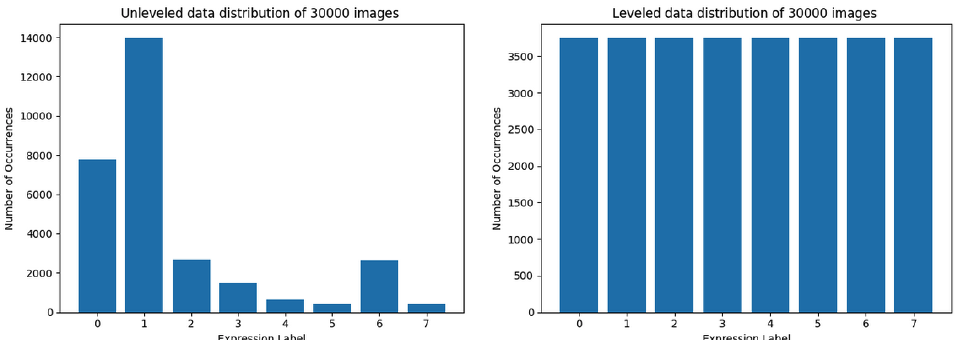
Figure 3. Data distribution of training set limited to 30,000 images. At the left side is data distribution using the first method, at the right—using the second method.